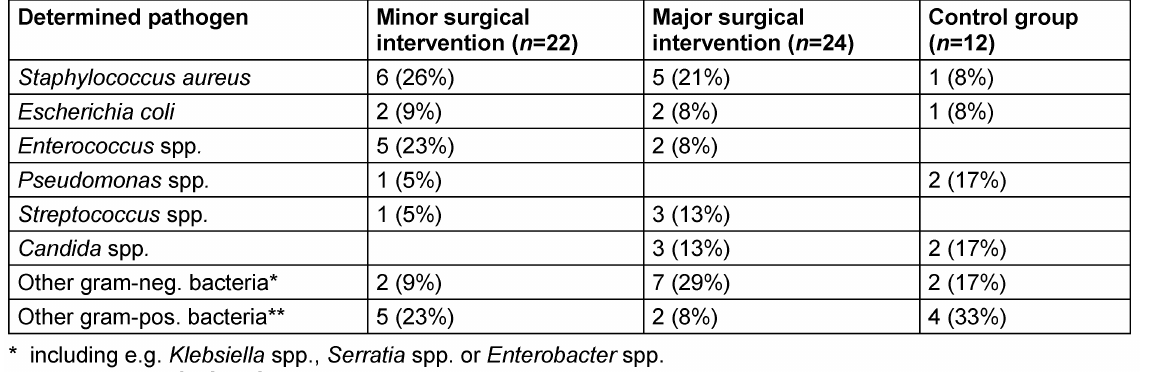
Table 2: Microbiological spectrum of blood stream infections. Detailed information about bacteria and fungi (number nand proportion in %) responsible for bloodstream infection. No significant difference between the groups was found in the microbiological spectrum (p0.241).